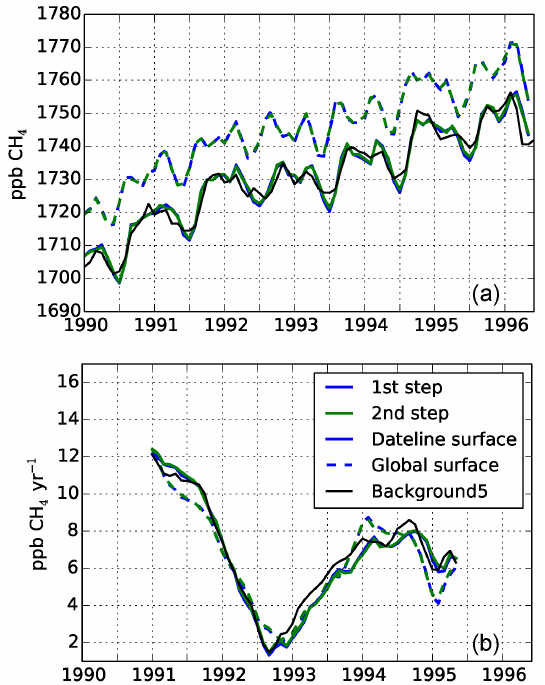
Figure A1. Surface mean CH 4 (a) concentrations and (b) growth rate for the two runs of the Base1 simulation at the dateline (solid lines) and global mean (dashed lines). The black line shows the background mean concentrations based on five background stations.